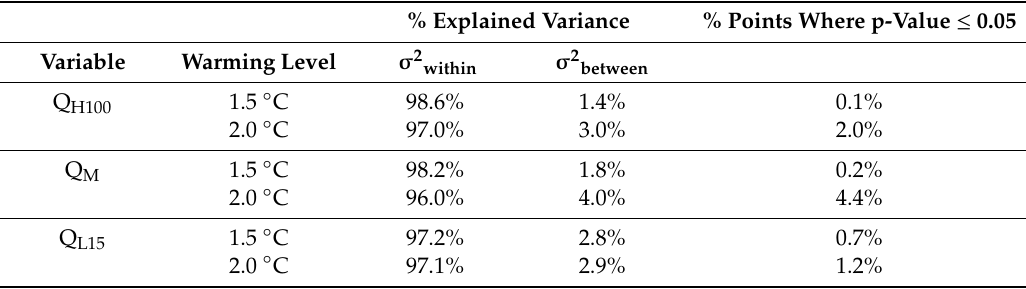
Table 2. Components of the total standard deviation for the considered ensembles expressed as percentages of explained